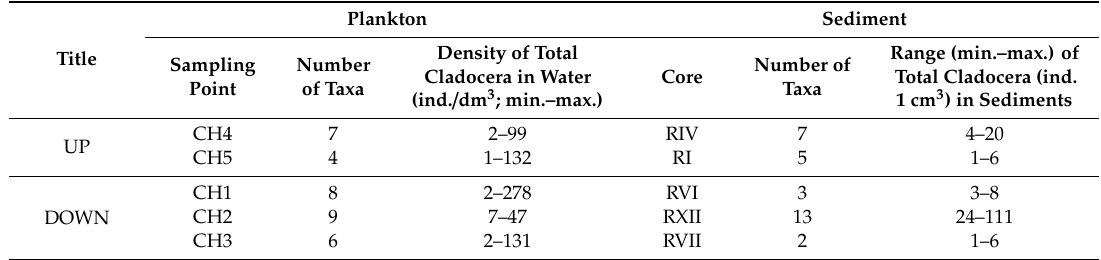
Table 3. Number of taxa and density of Cladocera in water and sediment of subsidence